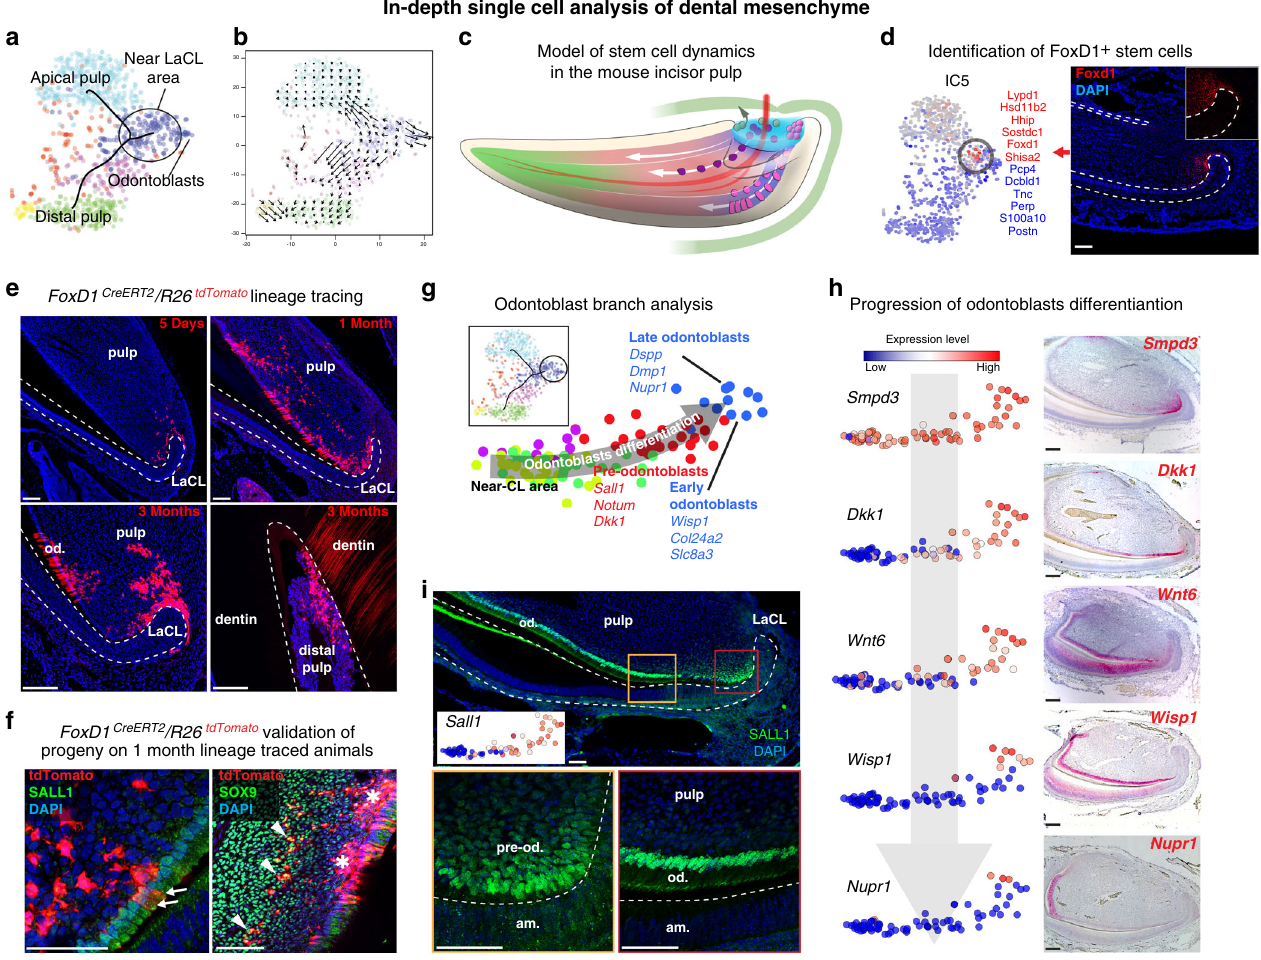
Fig. 5 Developmental dynamics of dental mesenchyme. a Analysis of mouse-incisor dental mesenchymal cells isolated for separate analysis from general dataset. Colors show unbiased clusters. The principal tree correctly captures positions of mature mesenchymal derivative and progenitor populations. b Analysis of RNA velocity shows major directions of cell progression in the transcriptional space. The arrow start- and endpoints indicate current and predicted future cell states. c Model of stem-cell dynamics in mesenchymal compartment with relation to dental follicle. d Prediction and validation of spatially restricted Foxd1 + stem cells. The Foxd1-associated axis was selected for validation, and is shown on t-SNE (genes with the strongest positive and negative associations are shown in red and blue respectively). Foxd1 + cells (in situ hybridization) are located in the mesenchyme surrounding the labial cervical loop. e Lineage tracing of FoxD1 CreERT2 /R26 tdTomato strain con fi rmed the predicted stem-cell nature of Foxd1 + mesenchymal cells. In short-term tracing (5days) tdTomato + cells are predominantly around LaCL in contrast to long-term (1-month-long and 3 months) tracing where pulp and odontoblast progeny are observed. Importantly, tdTomato + cells are maintained in their original position in the long-term manner (3 months) and at the same time point tdTomato + distally located odontoblasts can be observed supporting the theory of Foxd1 + cells being a long-living mesenchymal stem cells. f Nature of Foxd1 + cells progeny con fi rmed by a combination of FoxD1 CreERT2 /R26 tdTomato tracing and SALL1 and SOX9 immunohistochemical stainings. FoxD1 CreERT2 /R26 tdTomato -traced cells contribute to both the SALL1 + odontoblasts (arrows) and SOX9 + pulp cells (arrowheads). Asterisks show the of subodontoblast layer FoxD1 CreERT2 /R26 tdTomato traced cells. g Variability of cells assigned to a branch leading to odontoblasts (inset) was reanalysed using principal component analysis. Colors mark fi ve clusters obtained by unbiased hierarchical clustering. Left-right axis re fl ects developmental stages of odontoblasts. h Gradual odontoblast differentiation (suggested in g ) from near-CL area into fully differentiated odontoblasts. Left: expression pattern acquired from scRNA-seq, right: in situ hybridization-based histological validations of the proximal part of the mouse incisor proving suggested gradual transition. i Spatial pattern of a discovered (pre)odontoblast transcription factor — SALL1 (Immunohistochemistry). (LaCL Labial Cervical Loop, pre-od. preodontoblasts, Od. Odontoblasts, Am. Ameloblasts). Scare bars: 50 µ signi fi cantly more homogeneous as compared to the pulpal same time, gene expression programs of mouse molar and distal populations of the incisor given the resolution of the current incisor pulp have noticeable expression differences in 379 genes measurements. Joint Conos clustering of incisor and molar ( p value < 10 − 2 , t -test group means comparison and at least two fold change in both Smart-seq2 and 10× Chromium datasets) datasets shows that molar mesenchyme falls into a single cluster (Supplementary Fig. 4f). Mouse-incisor apical genes tend to show shared with the distal mouse-incisor pulp (Supplementary Fig. 4a, high expression in a Smoc2 + compared to Smoc2 − human apical b). Analysis of mesenchyme heterogeneity using separately 10× papilla. On the other hand, mouse-incisor distal genes tend to and Smart-seq2 platforms corroborated the heterogeneous show high expression in a Smoc2 − and not Smoc2 + human apical population structure of mouse incisor and homogeneous distal- papilla. In adult teeth, mouse-incisor distal genes are uniformly like population of mouse molar (Supplementary Fig. 4d, e). At the